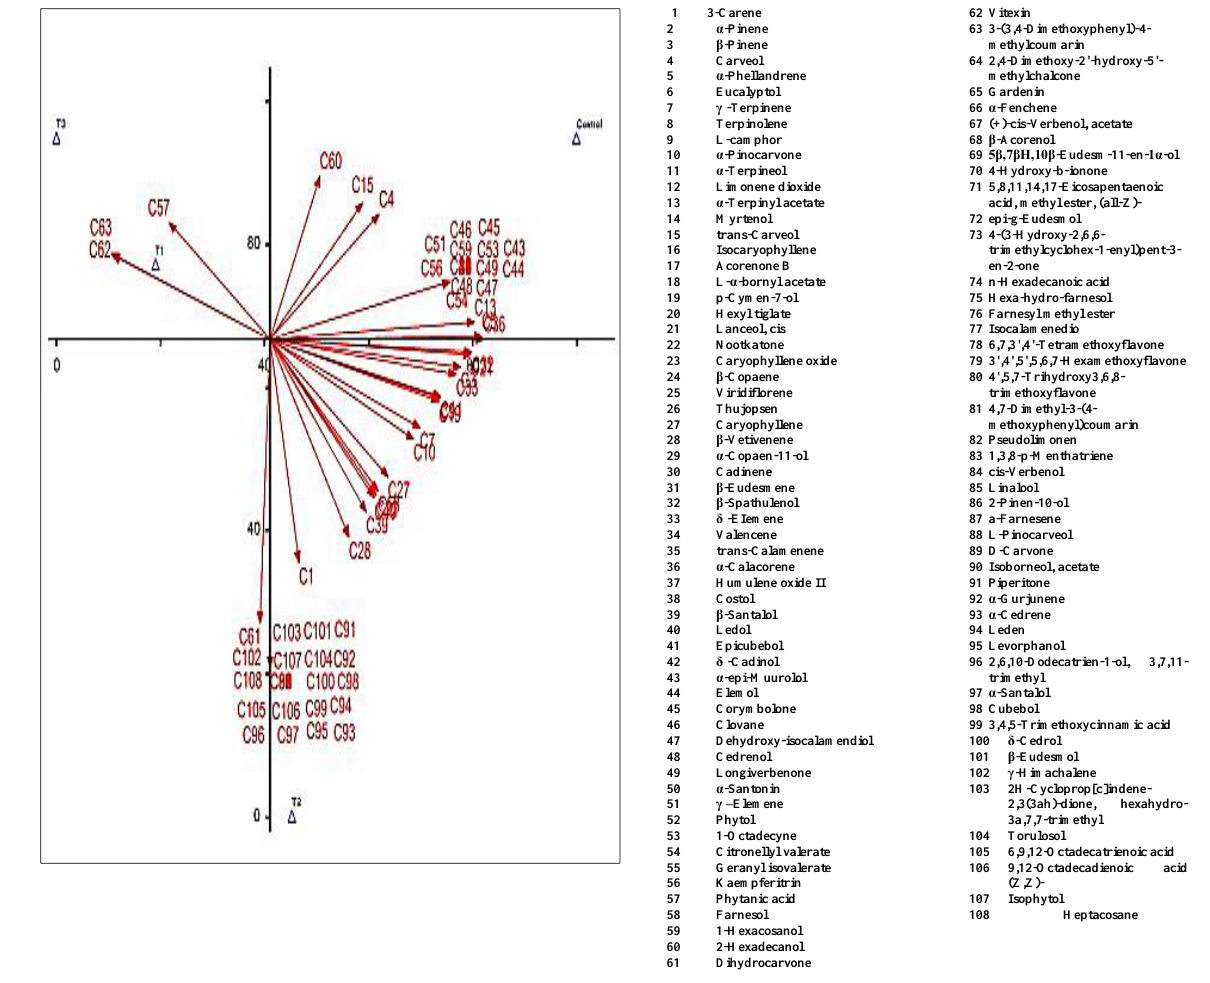
Figure 4. Principal component analysis (PCA) of the essential oil extracted from untreated and treated lavender plants with paclobutrazole.